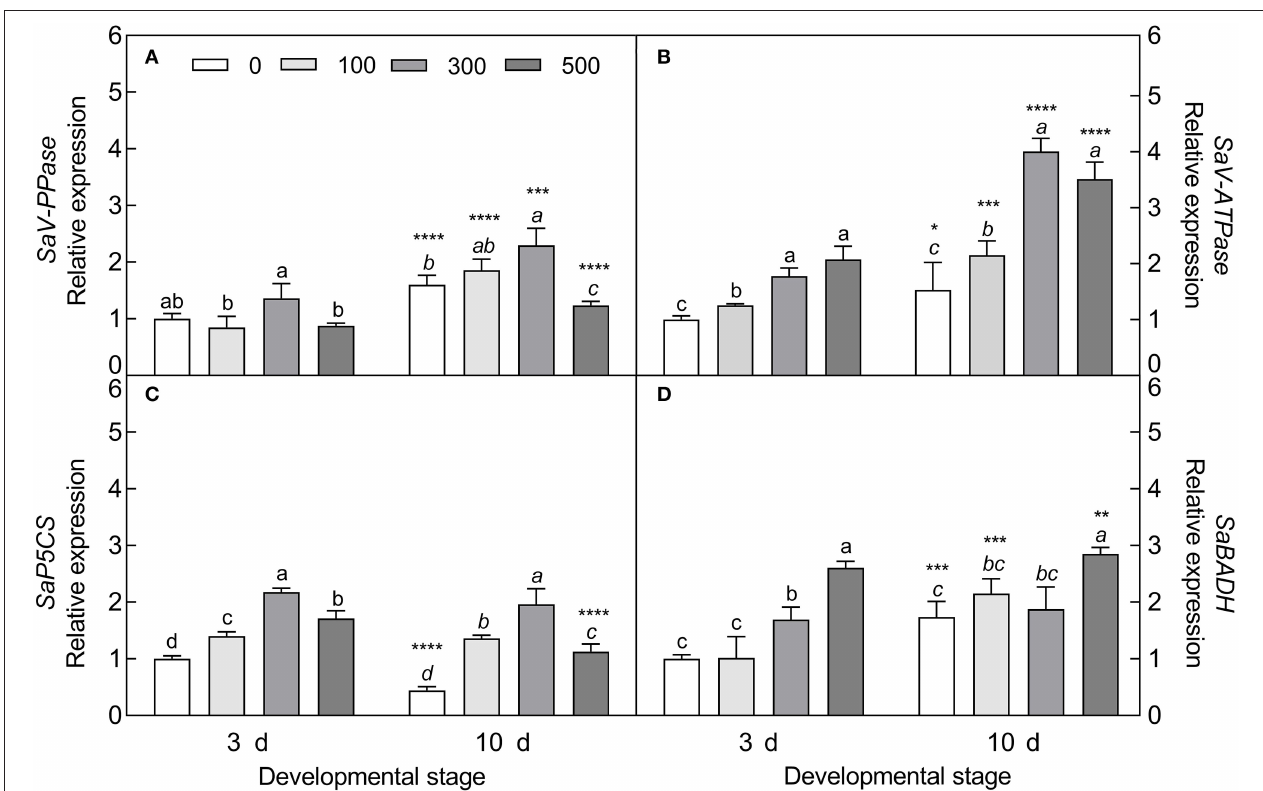
FIGURE 11 | Expression patterns of primary metabolite-related genes during seedling development under salt stress. (A) Vacuolar pyrophosphatase gene ( V-PPase ), (B) vacuolar ATP synthase gene ( V-ATPase ), (C) pyrroline-5-carboxylate synthase gene ( P5CS ), and (D) betaine aldehyde dehydrogenase gene ( BADH ). 3 d and 10 d represent 3 and 10 days after seedling emergence, respectively. 0, 100, 300, and 500: different NaCl concentrations (mM). Bars with different lowercase letters of the same developmental stage indicate significant differences ( P < 0.05) at different salt concentrations; *, **, ***, and **** indicate a significant difference between 3 d and 10 d at the same salt concentration at the 0.05, 0.01, 0.001, and 0.0001 levels, respectively. Values are means ± SE of six